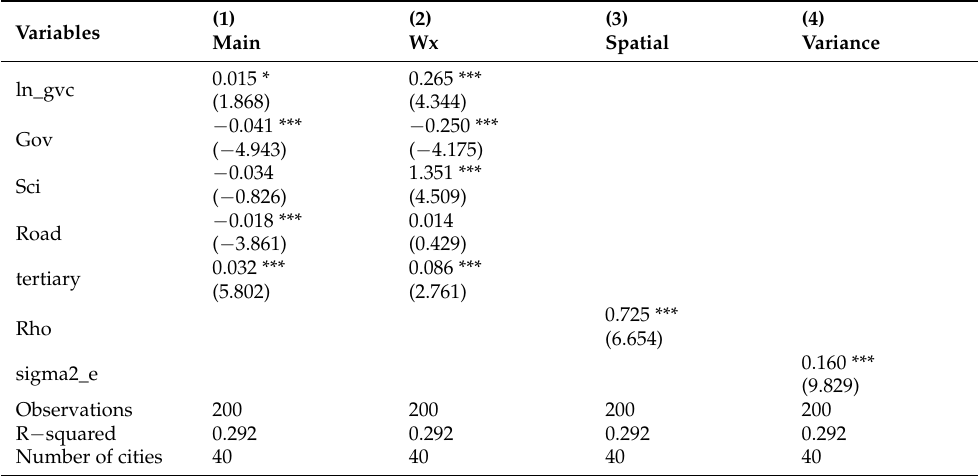
Table 9. Regression results of the living standards of regional